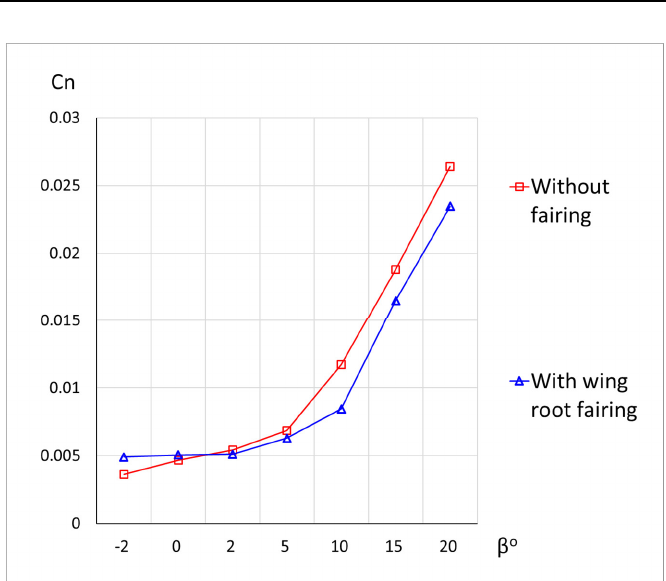
Figure 20. Yaw moment coefficient of the model with and without wing root fairing.